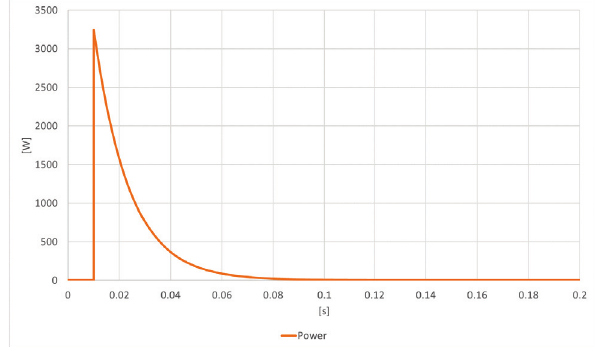
Fig. 3. Power dissipation on pre-charge resistor.